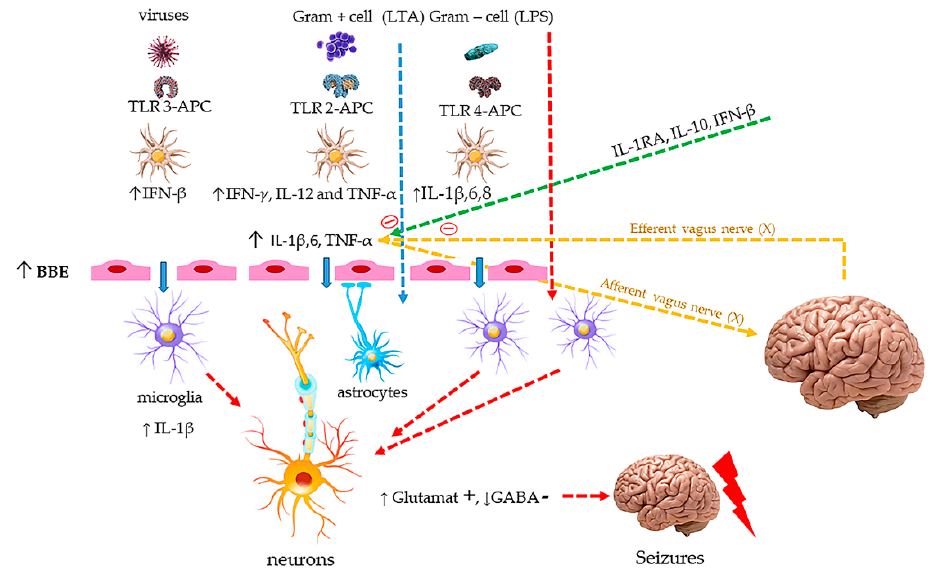
Figure A1. Pathogenic mechanisms of FS in different infections (viral and bacterial-Gram positive and Gram-negative).